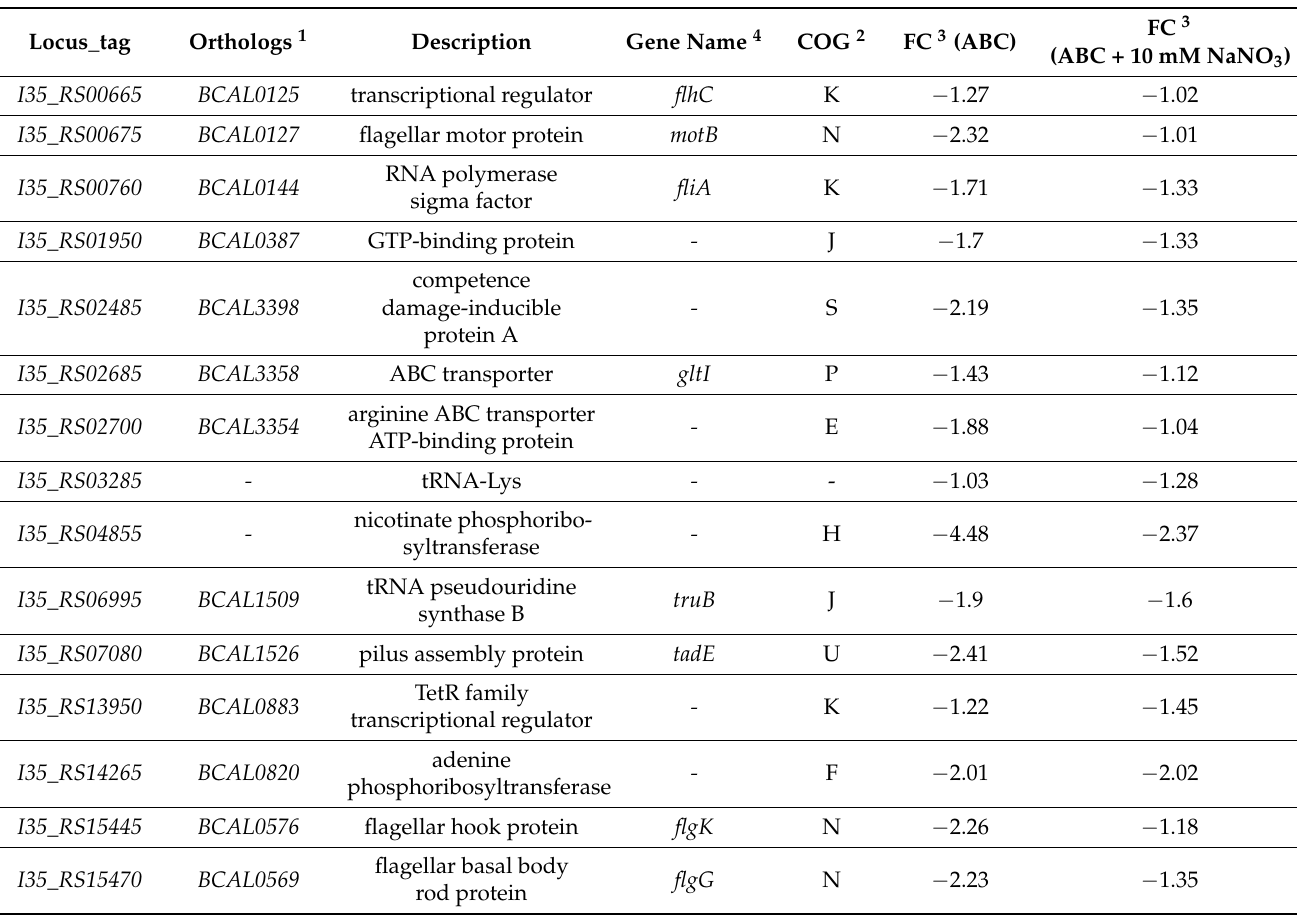
Table 2. List of the 20 identified common fitness determinants for anoxic survival of B. cenocepacia